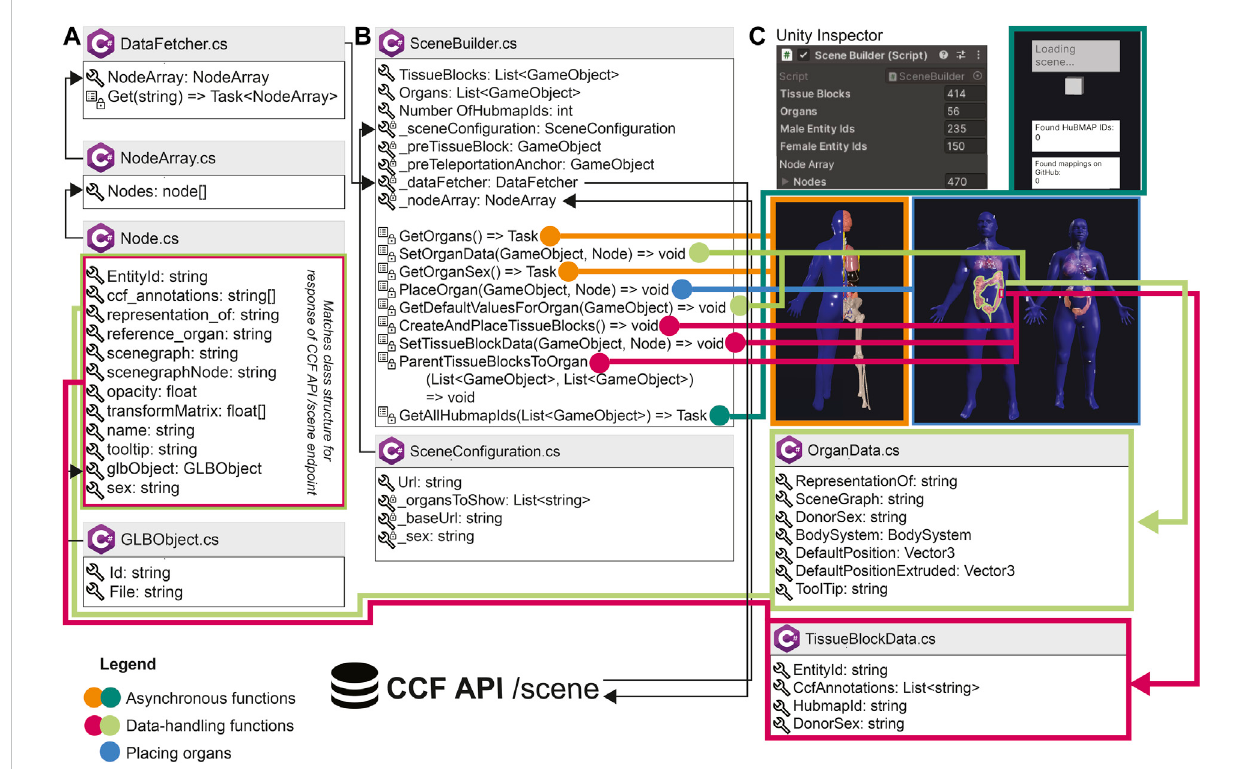
FIGURE 3 Architecture of the HRA Organ Gallery v0.6. Boxes with the C# logo signify a C# class or struct. A wrench symbolizes a property or fi eld; a list symbolizes a method; private properties, fi elds, or methods have an added lock symbol. In some cases, we only show a selection of properties, fi elds, methods,andeventsforaclass. List < T > and Array []refertocollectionsandarrays. Task or Task < T > denotesanasynchronousfunction(with < T > meaning that a type is promised as return). (A) DataFetcher and its associated classes are used to retrieve data. (B) SceneBuilder sets up the 3D content. (C) SceneBuilder is derived from Unity ’ s native Monobehaviour class so it can be added to a GameObject in the Unity scene. The Unity inspector then shows the SceneBuilder component, including the number of tissue blocks and organs received from the API, which is helpful for our developers. Note that